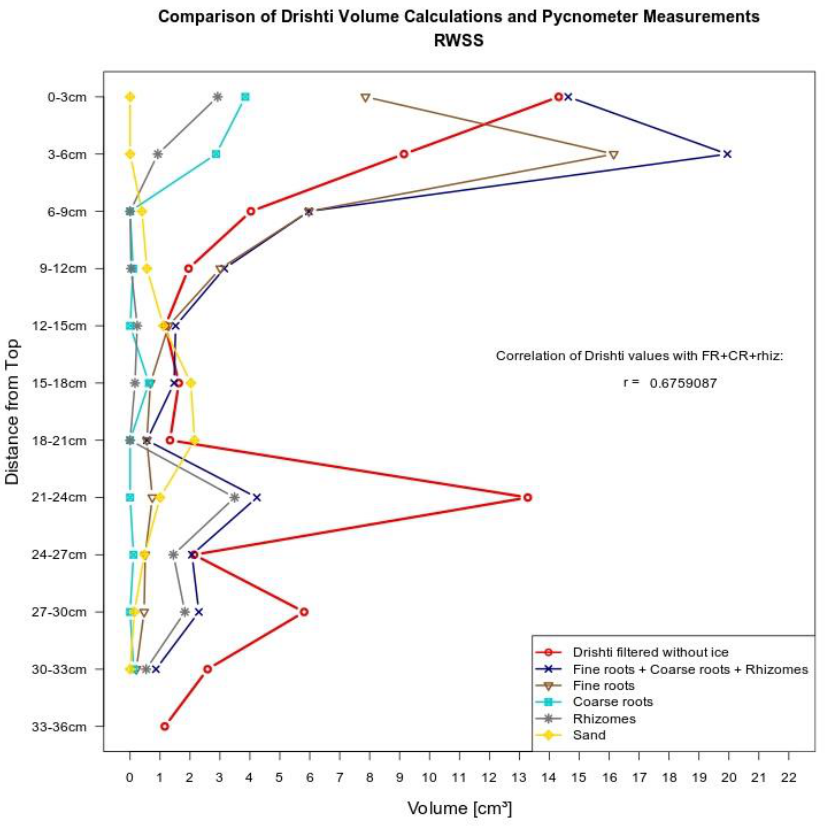
Figure 10. Drishti volume calculations (RWSS with size filter and ice removed) and pycnometer measurements.